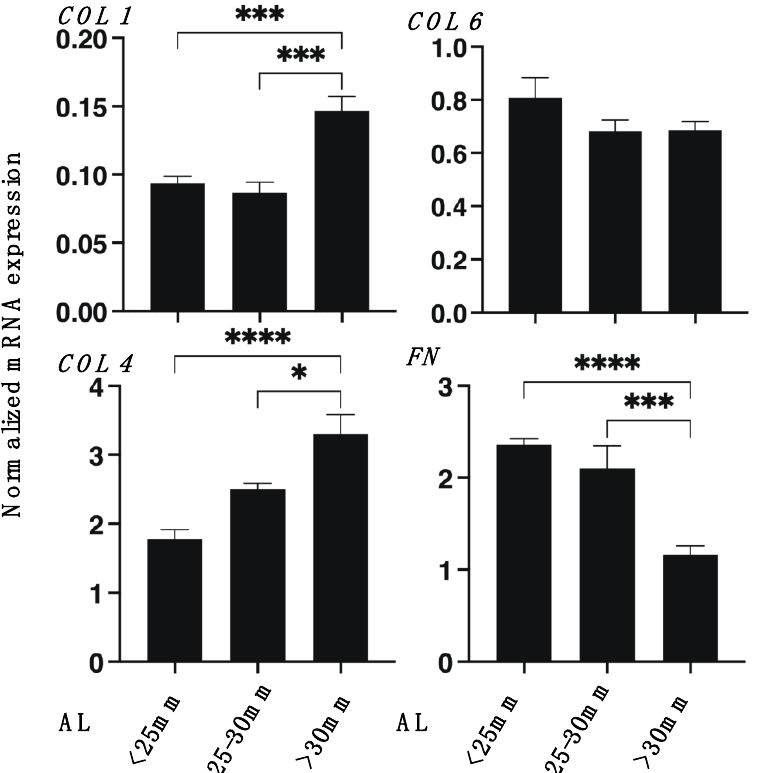
Figure 3. qPCR analysis of ECM in the 3D spheroids of human scleral stroma fibroblasts (HSSFs). Among three different ALs, <25 mm, 25–30 mm, or >30 mm, 3D spheroids of HSSFs at Day 5 were subjected to a qPCR analysis of ECM proteins including COL1 , COL4, COL6, and FN . All experiments were performed in duplicate using fresh preparations ( n = 5, each). Data are presented as the arithmetic mean ± standard error of the mean (SEM). * p < 0.05, *** p < 0.005, **** p < 0.001 (ANOVA followed by Tukey’s multiple comparison test).